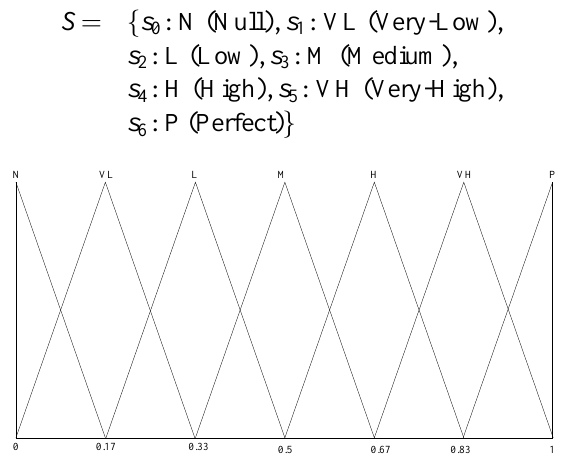
Fig. 2. A set of seven terms with its